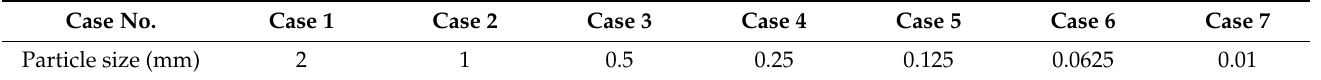
Figure 4. Model built using the hexagonal closest packed method. Table 2. Particle size parameters related to changes in the mechanical parameters.